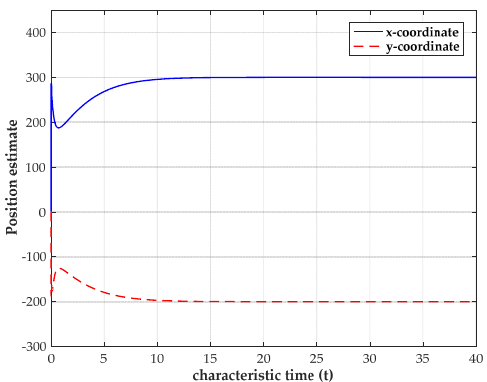
Figure 5. Transient behavior of the estimated source coordinates using noise-free TOA measurements with source position located at ( 300, − 200 )